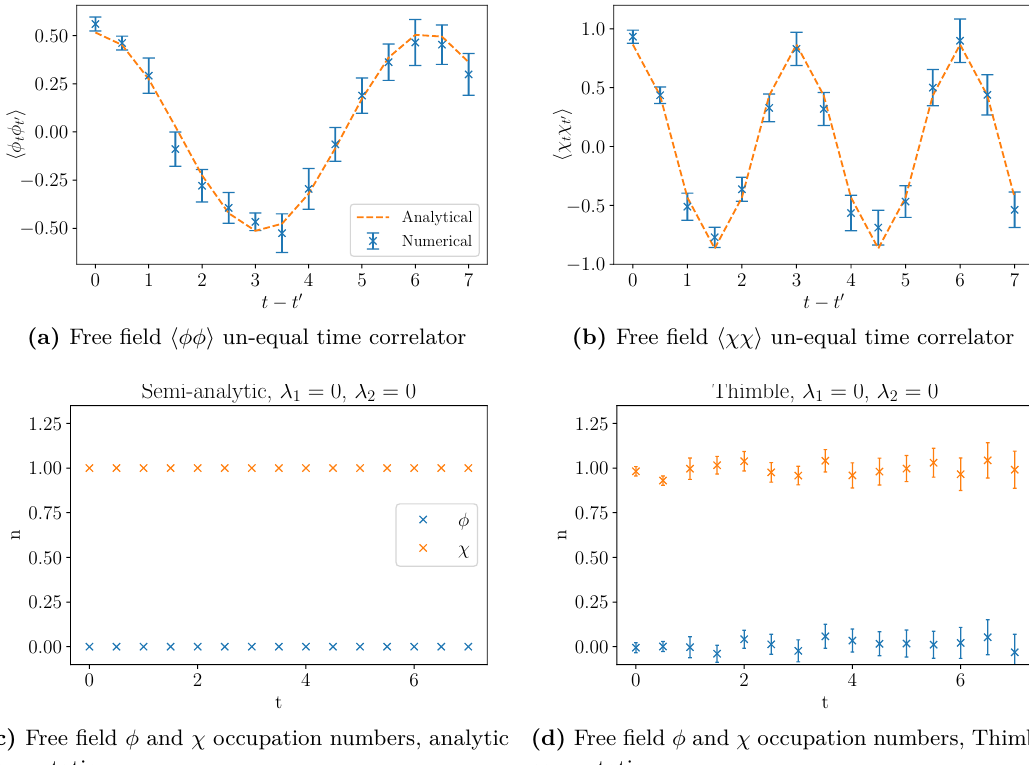
Figure 9. The un-equal time correlator (top) and occupation number (bottom) for two free fields, comparing semi-analytic results to Thimble